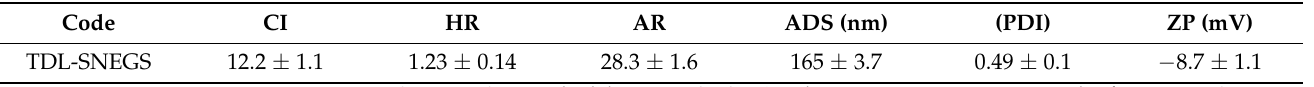
Table 5. Flow and reconstitution properties of tadalafil-loaded self-nanoemulsifying granules